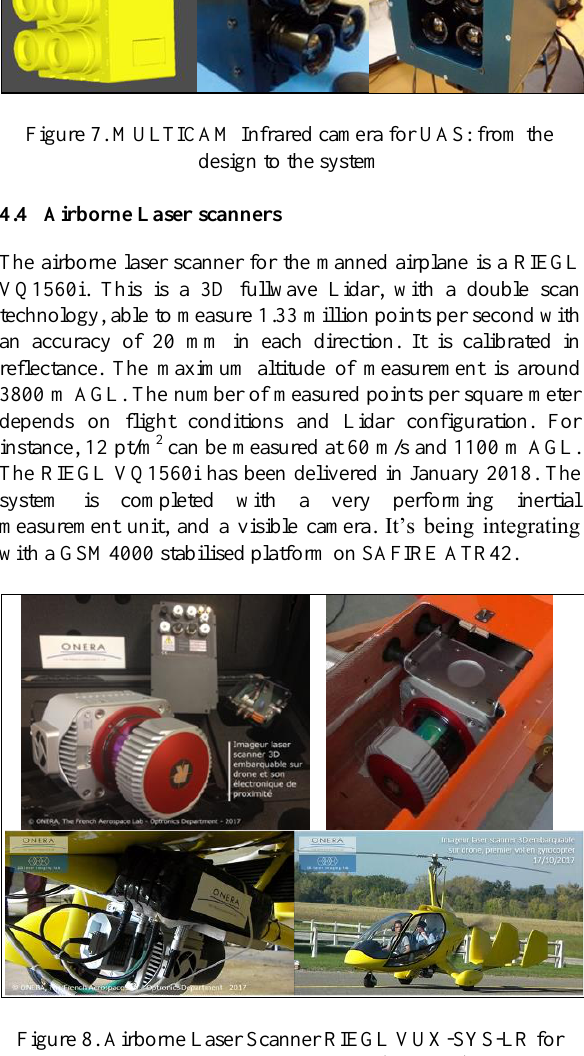
Figure 8. Airborne Laser Scanner RIEGL VUX-SYS-LR for UAS; integration on BOREAL UAS (top right) and on gyrocopter (bottom)